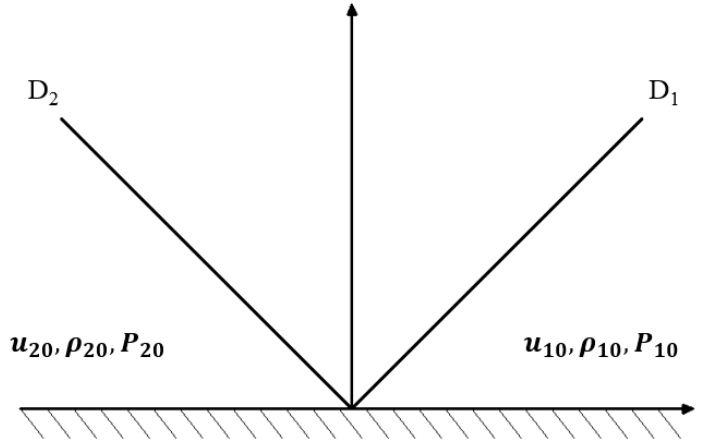
Figure 18. The left and right characteristic lines of the projectile for the collision of different media. Right wave: